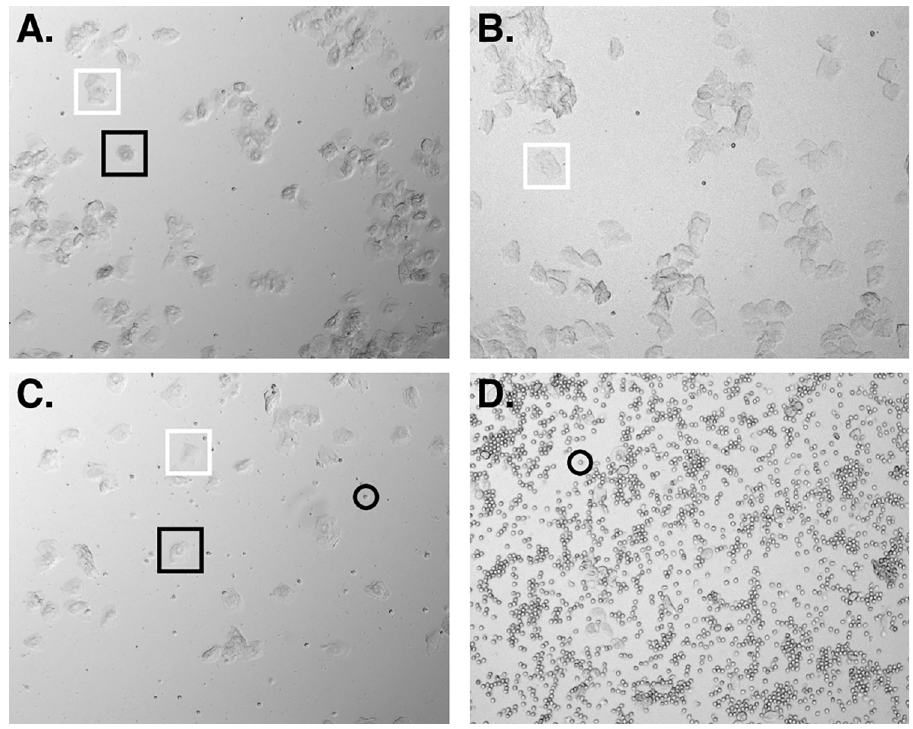
Fig 2. Example images of estrous stages from unstained vaginal cytology. Estrous cycle stage is determined by the presence of specific cell types. Nucleated epithelium, rounded with visible nucleus ( black boxes ). Cornified epithelium, flat, irregularly shaped with no visible nucleus ( white boxes ). Leukocytes, small and spherical ( black circles ). A. Proestrus, majority nucleated epithelium. B. Estrus, majority cornified epithelium. C. Metestrus, mix of cornified epithelium, nucleated epithelium, and leukocytes. D. Diestrus, majority leukocytes.